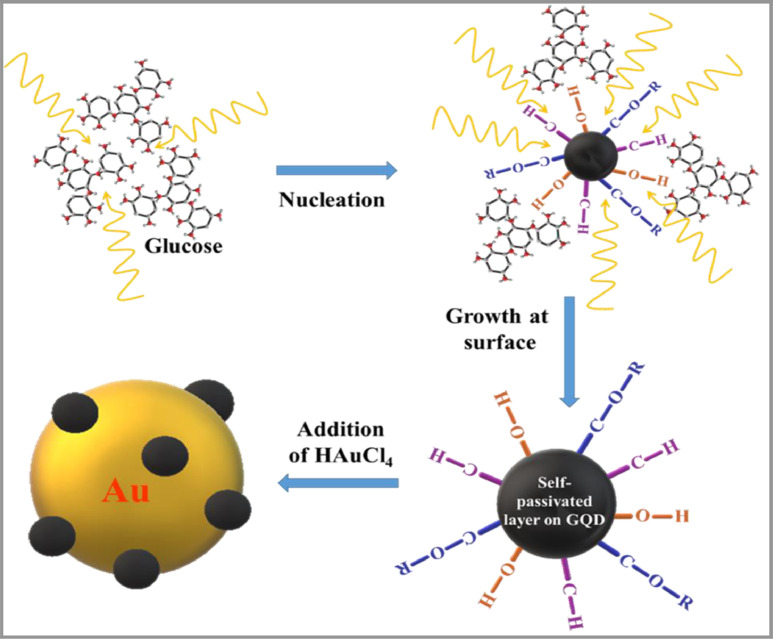
Schematic for synthesis of GQD-Au hybrid nanoparticle.